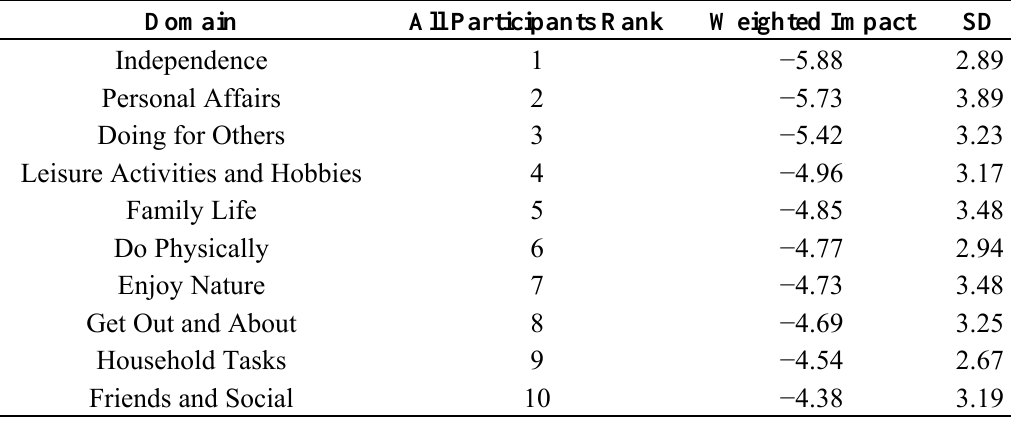
Table 3. Top 10 most negatively impacted MacDQoL